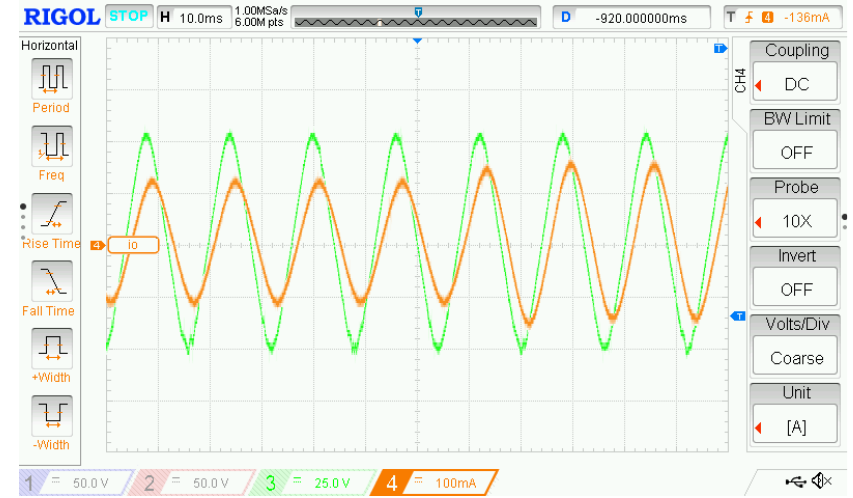
Figure 27. Measurement of output voltage and output current with an RLC load. A system is tested using a non-linear load. A full bridge rectifier is used to test the system. The waveforms in Figure 28 represent the inverter output voltage and output current along with the voltage measured across the diode bridge